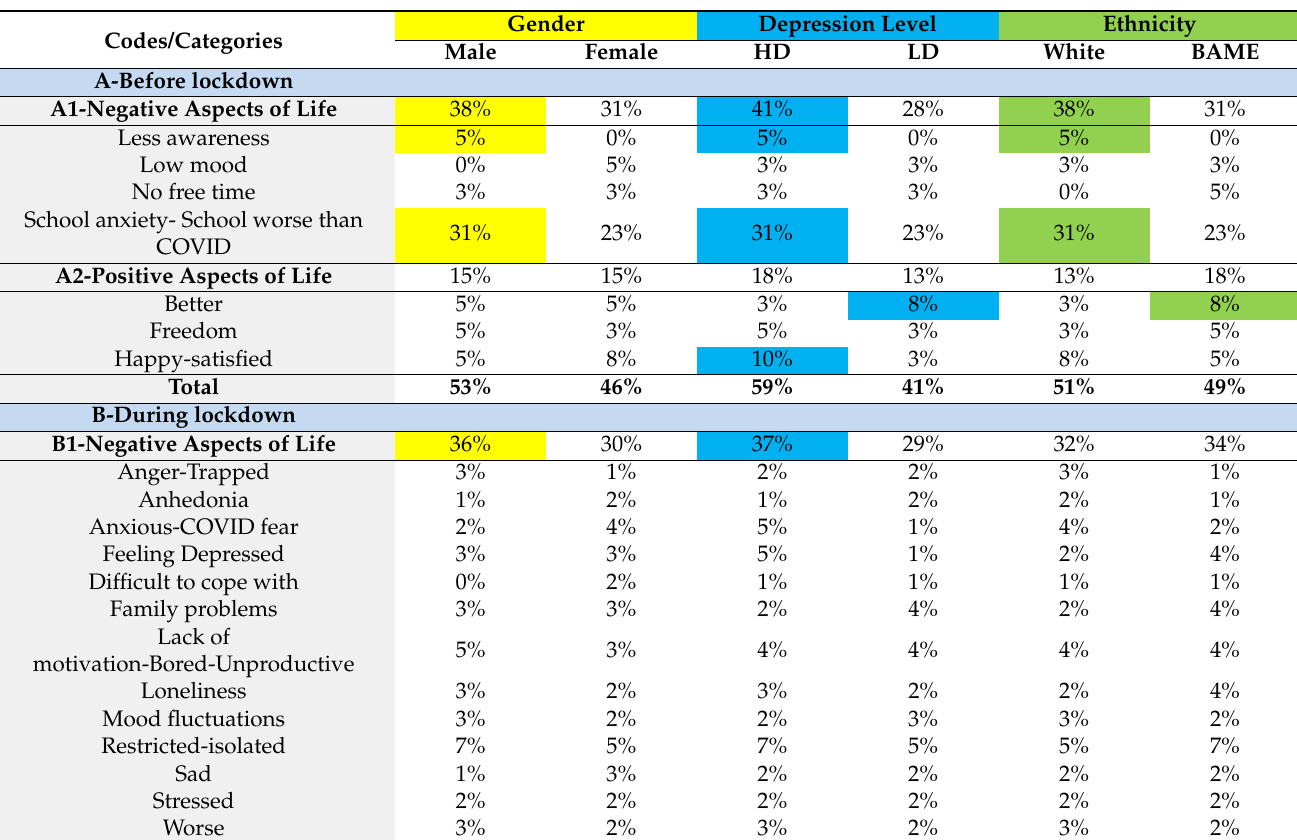
Table A2. The effects of COVID (before and after) and gender and ethnicity on mood and life